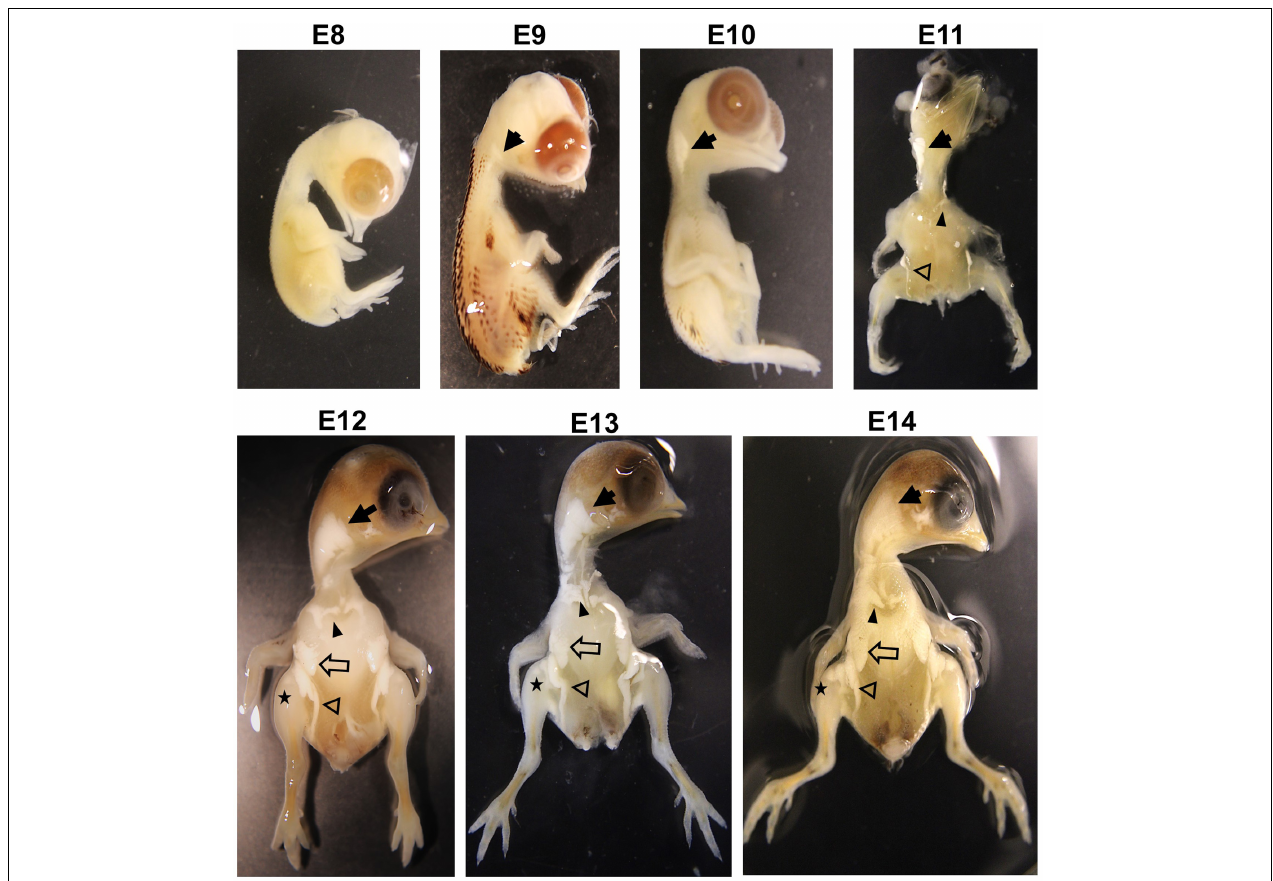
FIGURE 1 | Visualization of fat pad on embryos in quail with 1% KOH at E8, E9, E10, E11, E12, E13, and E14. Solid arrow, neck fat; solid arrowhead, supraclavicular fat; opened arrow, breast fat; opened arrowhead, inguinal fat; star, leg fat. Images are not to scale.